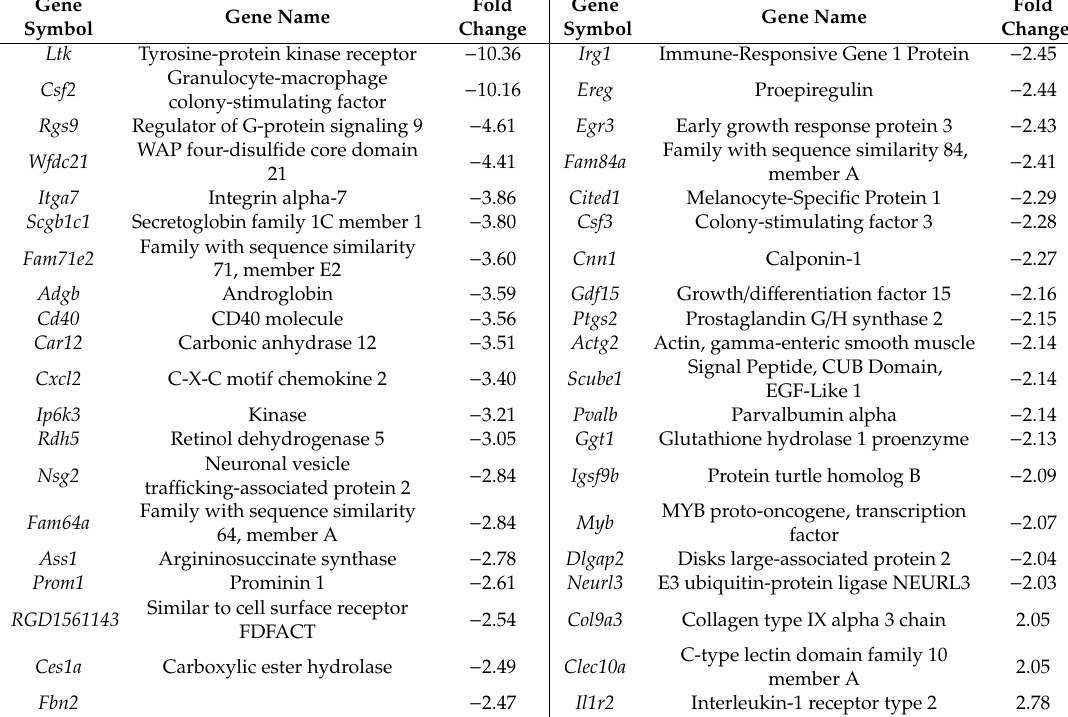
Table 2. summary of common gene responses comparing 3D tendon constructs treated with Il-1 β alone (+/ − Il-1 β ) or exposed to PEMF under Il-1 β (+PEMF +/ − Il-1 β ).